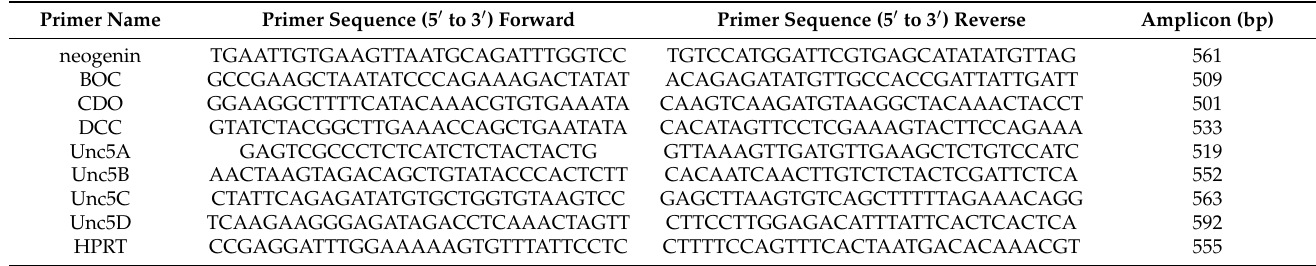
Table 3. RT-qPCR primer sets for mouse netrin receptors and